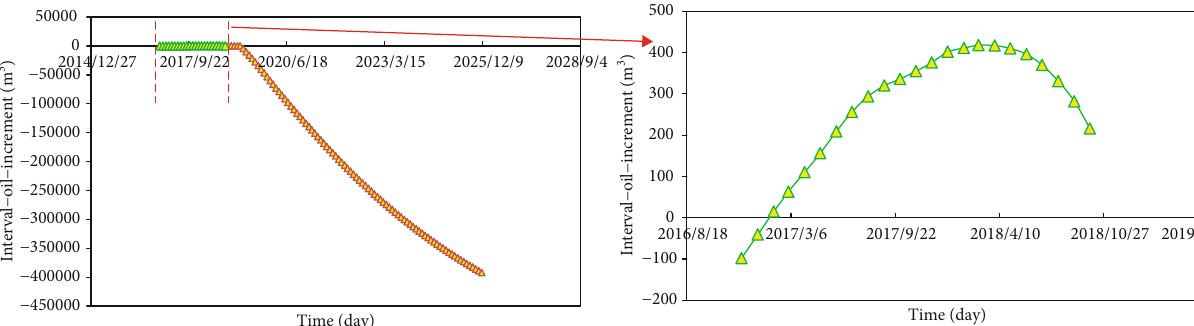
Figure 18: Change of